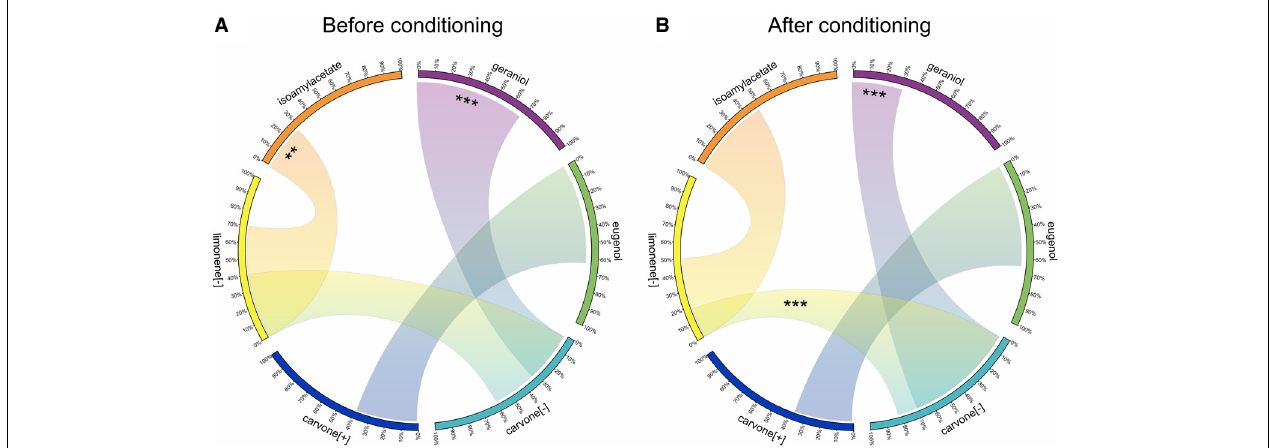
link is, the more preferred the odor is. (A) Spontaneous odor preference before conditioning during the pretests. (B) Odor preference after conditioning with reinforcement on C[ − ] during the tests. Data are presented as means of ratio (number of licks for the bottle on the sum of the number of licks for the two bottles) over the two successive pretests/test days (Wilcoxon tests; ∗ p < 0 . 05; ∗∗ p < 0 . 01; ∗∗∗ p < 0 .